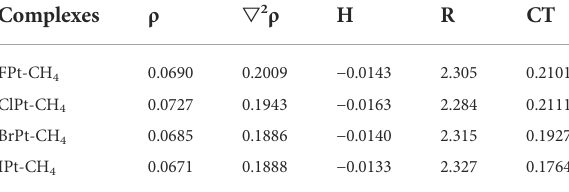
TABLE 4 Electron density ( ρ , a.u.), Laplacian ( ▽ 2 ρ , a.u.), energy density (H, a.u.), intermolecular distance (R, Å), and charge transfer (CT, e) at the XPt-CH 4 (X = F, Cl, Br, I)